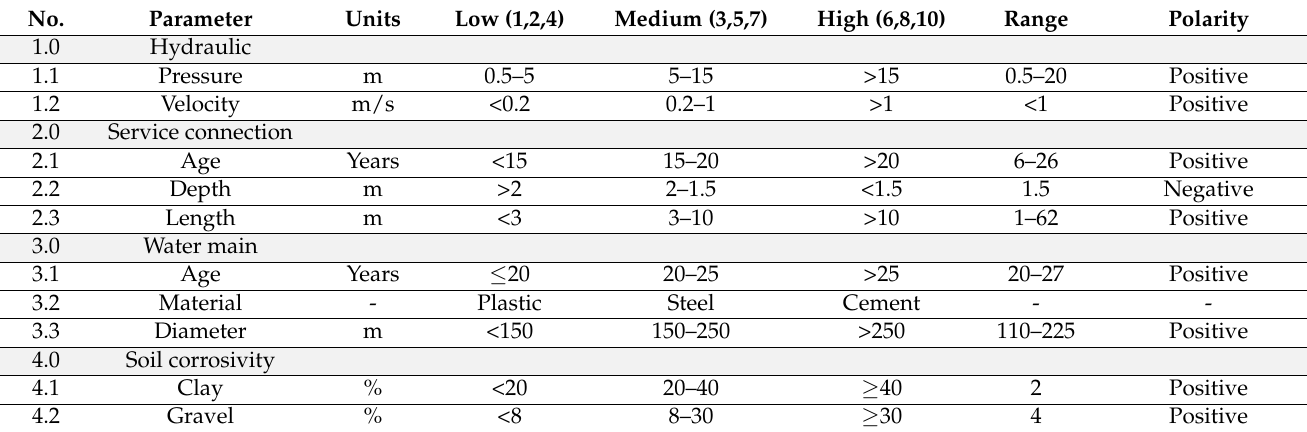
Table 1. Baseline data and universe of discourse